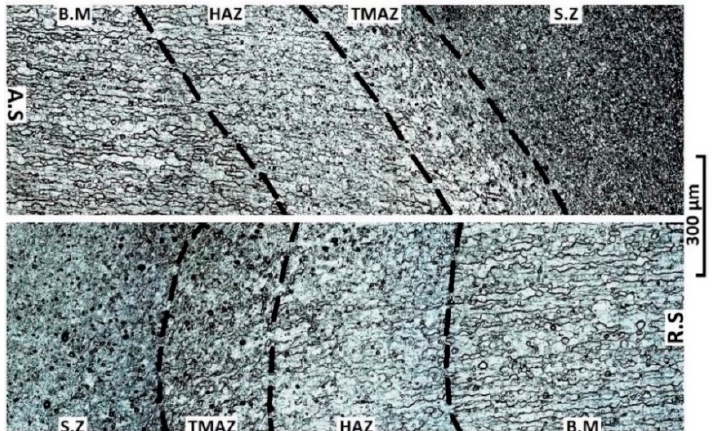
Figure 4. Microstructure of the grain distribution in the advancing side (A.S, top ) and the retreating side (R.S, bottom ) of the A6082-T6 weld (processed by etchant C).